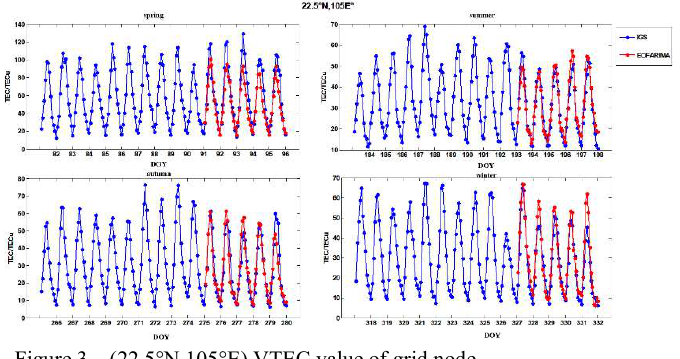
Figure 3 (22.5°N,105°E) VTEC value of grid node